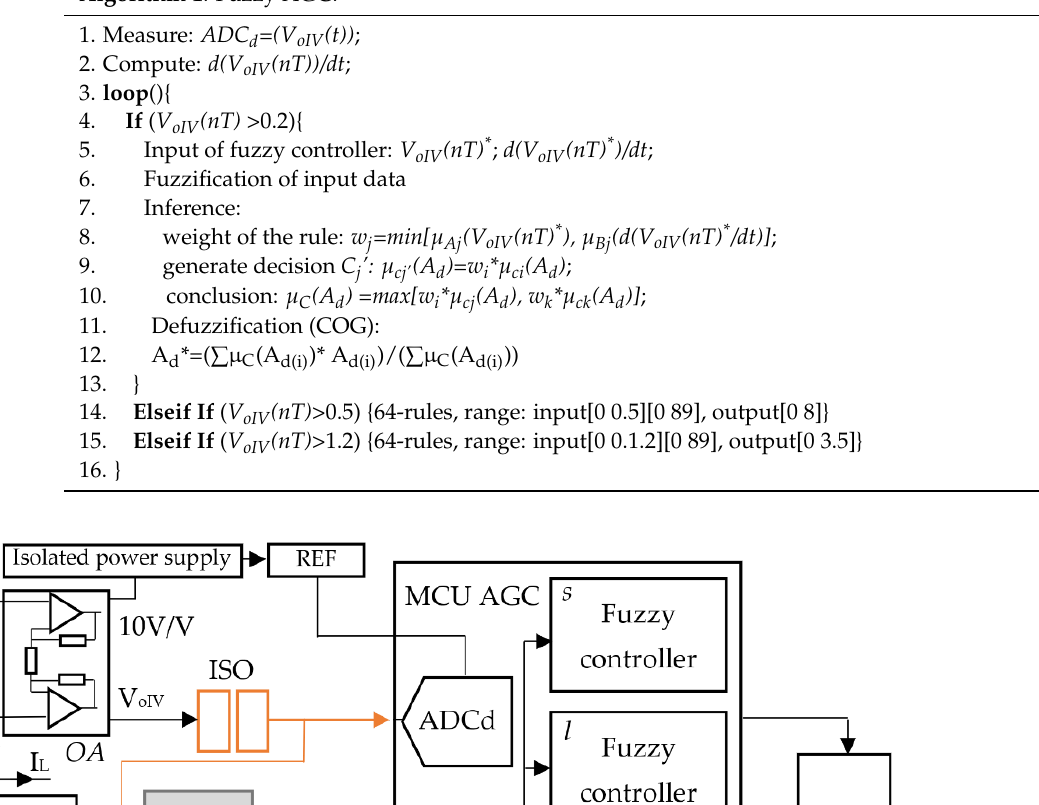
Algorithm 1 . Fuzzy AGC.